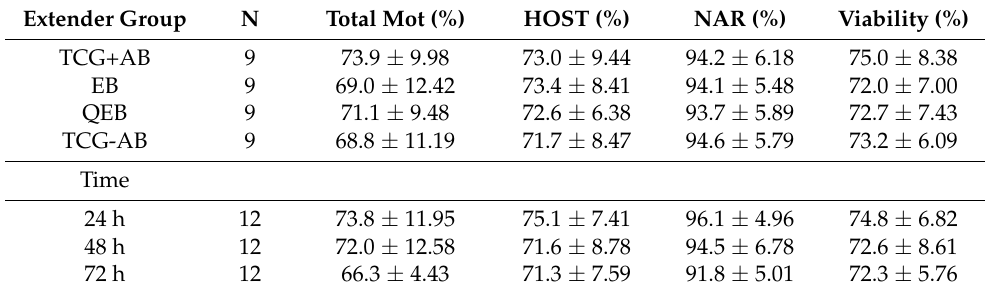
UTCG+AB: TCG extender supplemented with 100 IU/mL penicillin + 100 µ g/mL streptomycin. EB: TCG supplemented with EDTA (20 mM) and bestatin (10 mM). QEB: TCG supplemented with EDTA (20 mM),